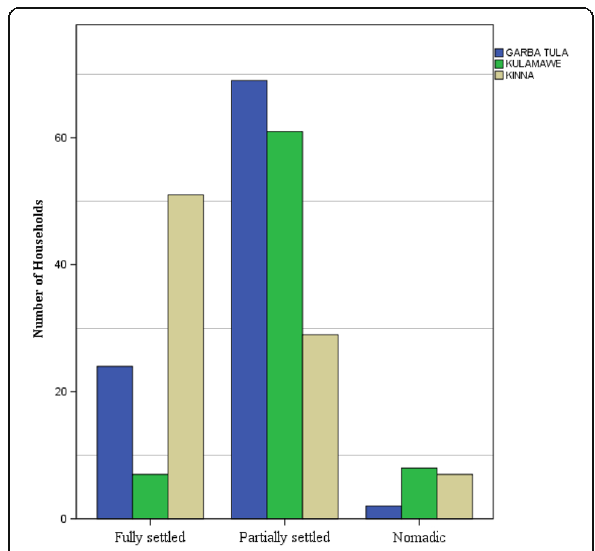
Figure 3 Number of households by mobility status and location